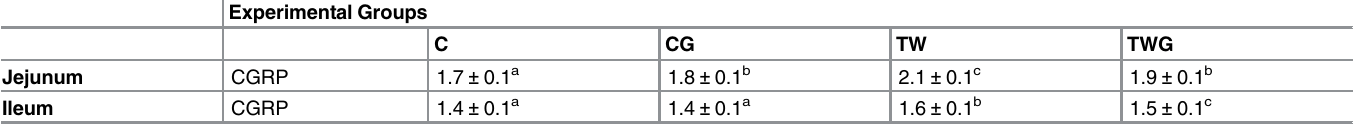
All the values are expressed as mean ± SEM (n = 8 animals per